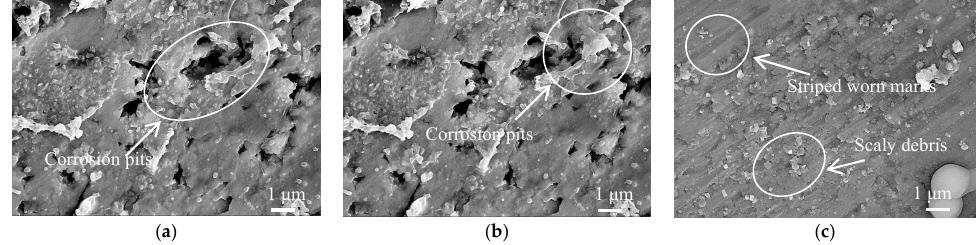
Figure 9. Morphologies of worn track on cold sprayed Al coatings before LR. ( a ) Wear load of 0.5 N; ( b ) Wear load of 1.0 N; ( c ) Wear load of 1.5 N. Materials 2018 , 11 , x FOR PEER REVIEW